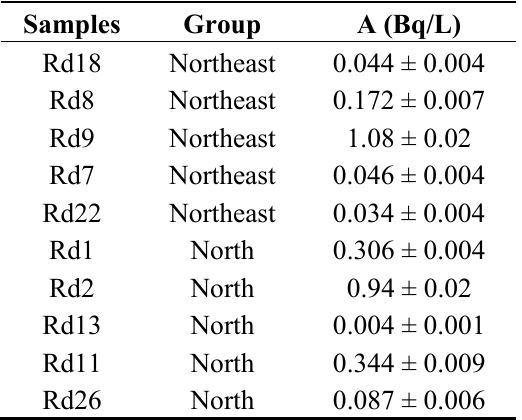
Table 2. Gross alpha activity values for water with radon activity concentrations higher than 10